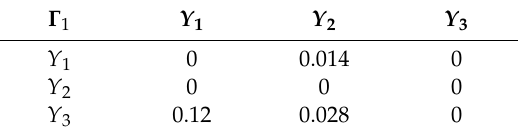
Table 7. The rejoice matrix Γ 1 .